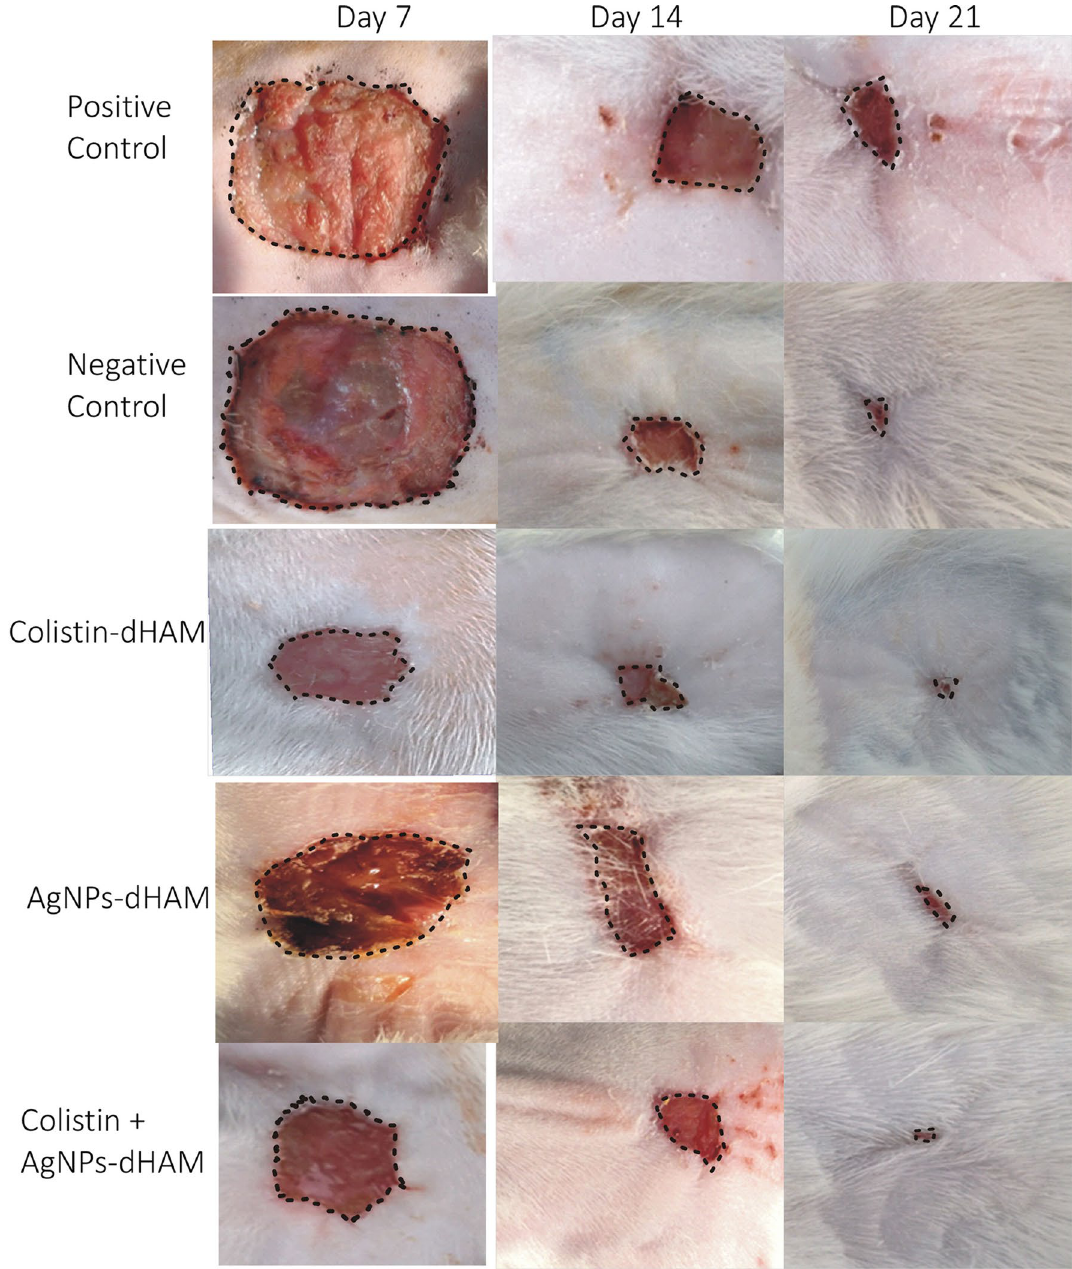
Figure 2. Wound healing in different dressing groups of rats against K. pneumoniae on days 7, 14 &